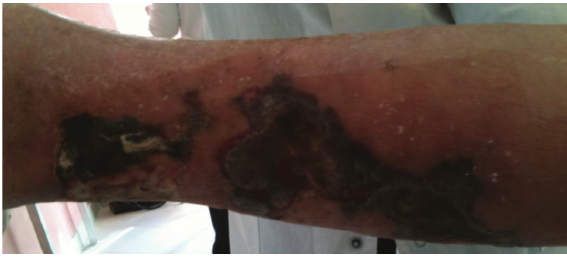
Figure 1: Extensive skin necrosis of the lower limb.